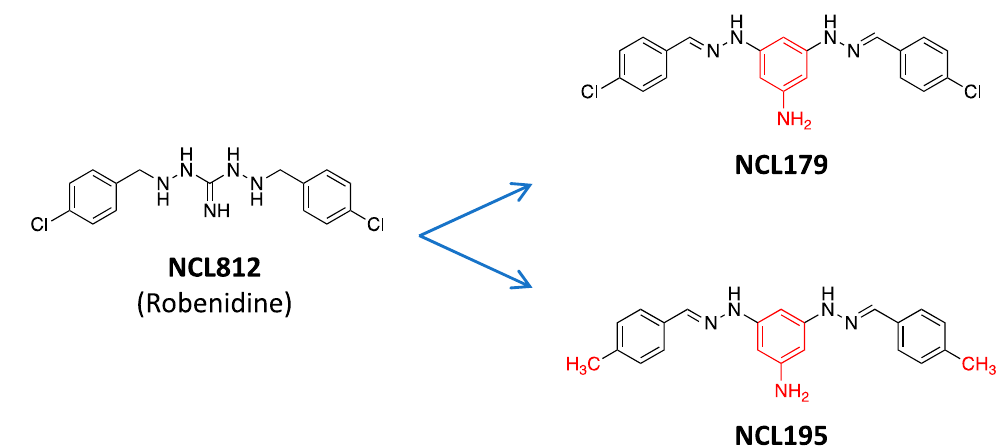
Figure 1. Chemical structures of NCL812 (Robenidine), NCL179 and NCL195. Red coloura- tion highlights the structural changes in NCL179 and NCL195 relative to NCL812. The guanidine to triaminopyrimidine novel bioisosteric modification of NCL812 yielded NCL179 (2,2 (cid:48) - bis [(4-chlorophenyl)methylene] carbonimidic dihydrazide) and NCL195 (4,6-bis(2-((E)-4- methylbenzylidene)hydrazinyl)pyrimidin-2-amine). NCL179 contains a halogen (chlorine) that distinguishes it from